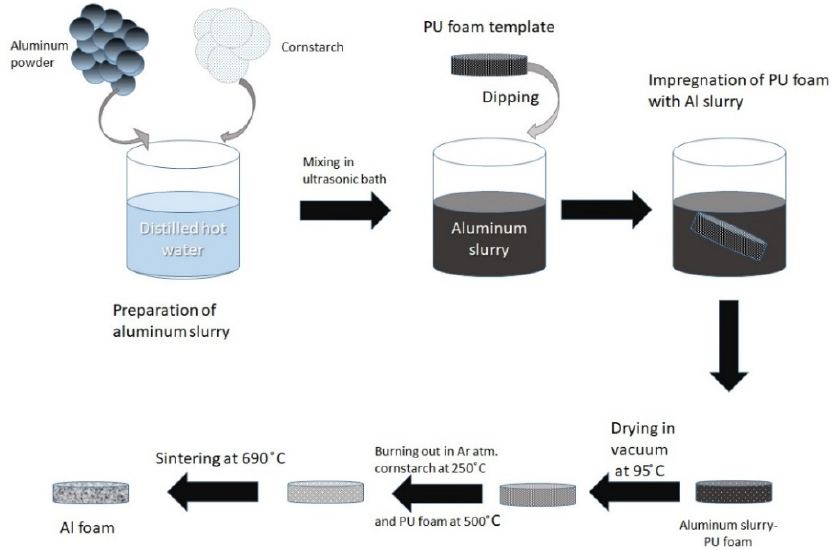
Figure 3. Schematic illustration of replication technique. Table 1. Conditions of binder and PU burning and sintering of aluminum foam sample.